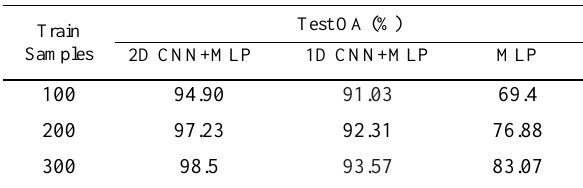
Table 2. Obtained classification results for different training samples